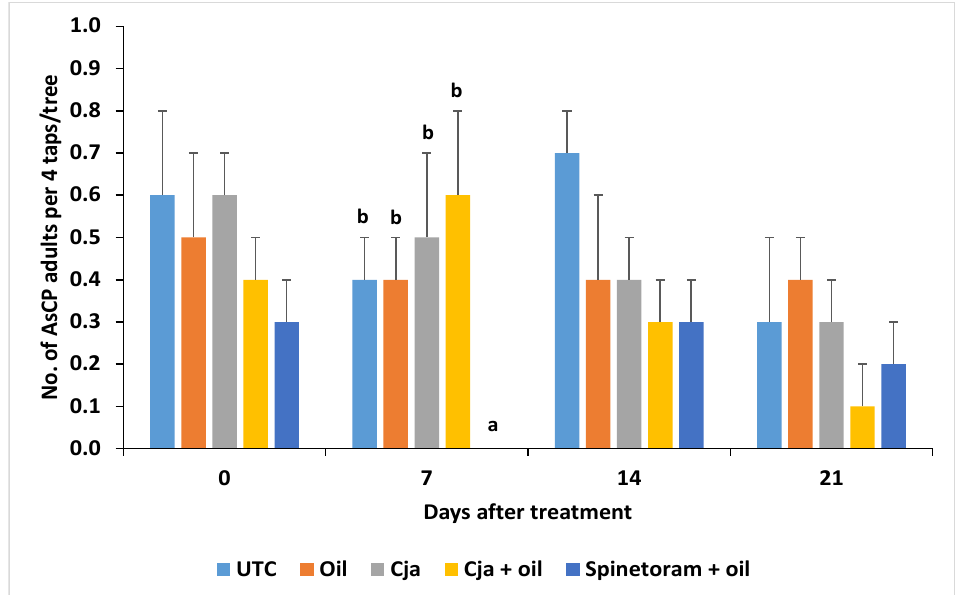
Figure 5. Mean number of AsCP adults per four taps per tree for each treatment at different days after treatment in Trial 2. The mean values with a different letter above the ±SE bar are significant for each day after treatment (LSD test; p < 0.05). There were no significant differences among the treatments ( p > 0.05) at 0, 14 and 21 days after treatment. The untransformed data are presented. UTC = untreated control; Cja = Cordyceps javanica .